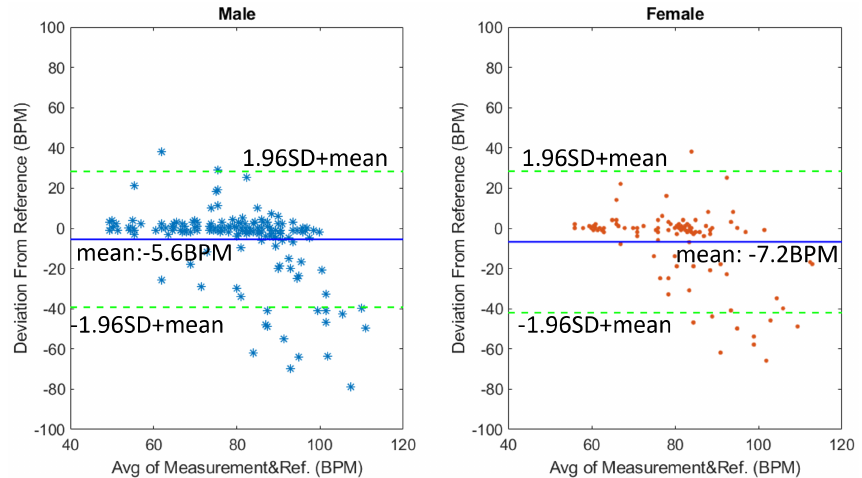
Figure 17. Bland–Altman plot for HR measurements within groups of: male ( left ) and female ( right ).